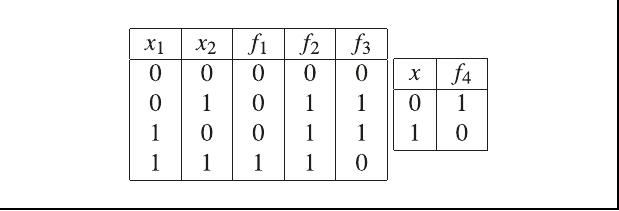
Table 1. Truth tables of basic Boolean